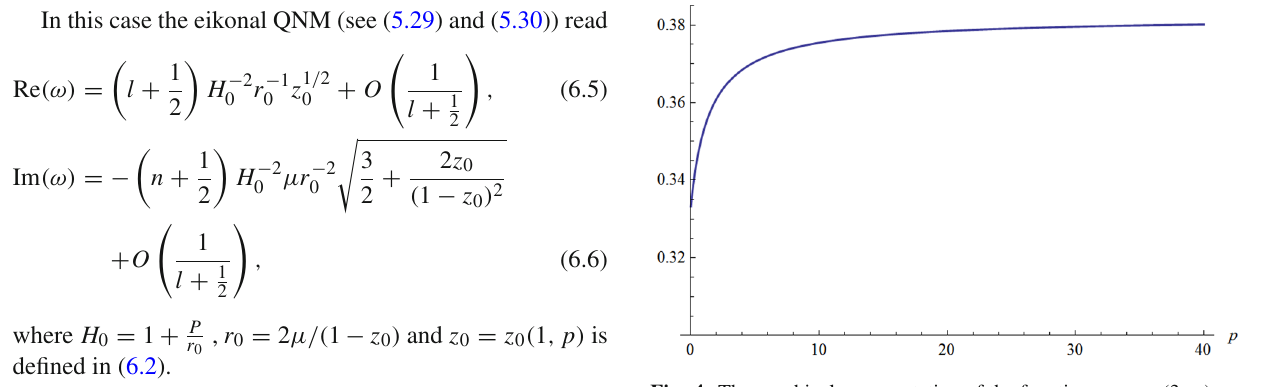
Fig. 4 The graphical representation of the function z 0 = z 0 ( 3 , p )